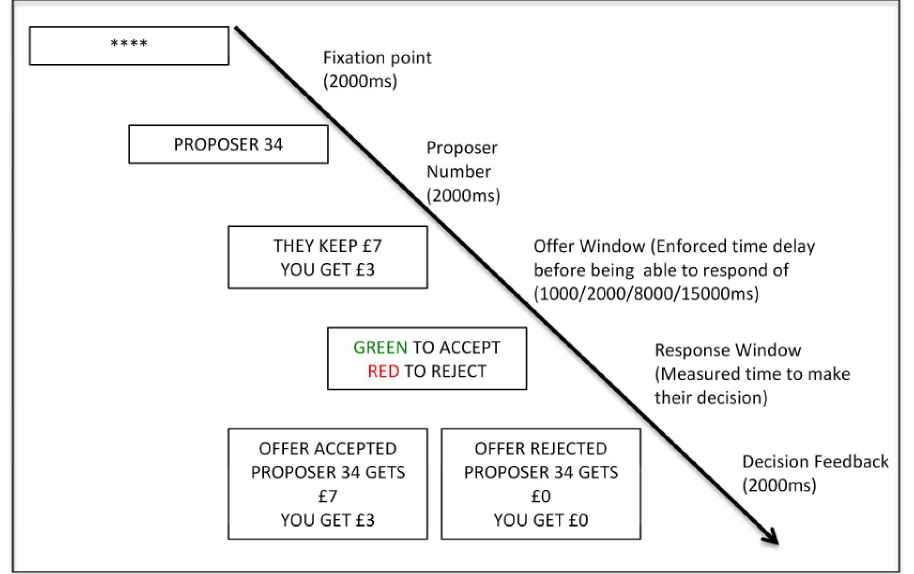
Figure 1. Schematic of the Ultimatum Game for the Responder.